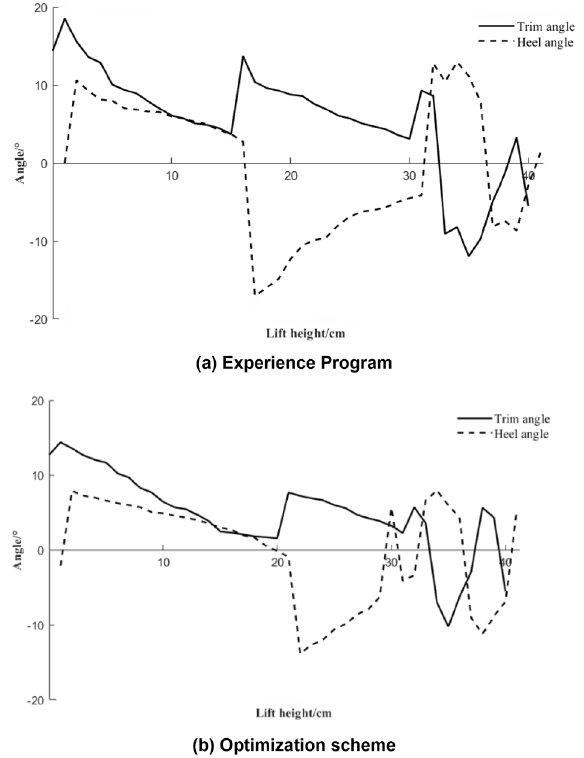
Figure 16. Comparison and analysis diagram of the heel and trim inclination